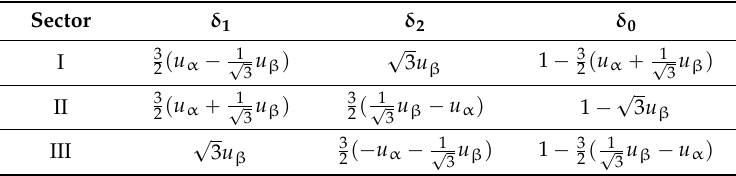
Table 1. Duty cycles calculated in half fundamental